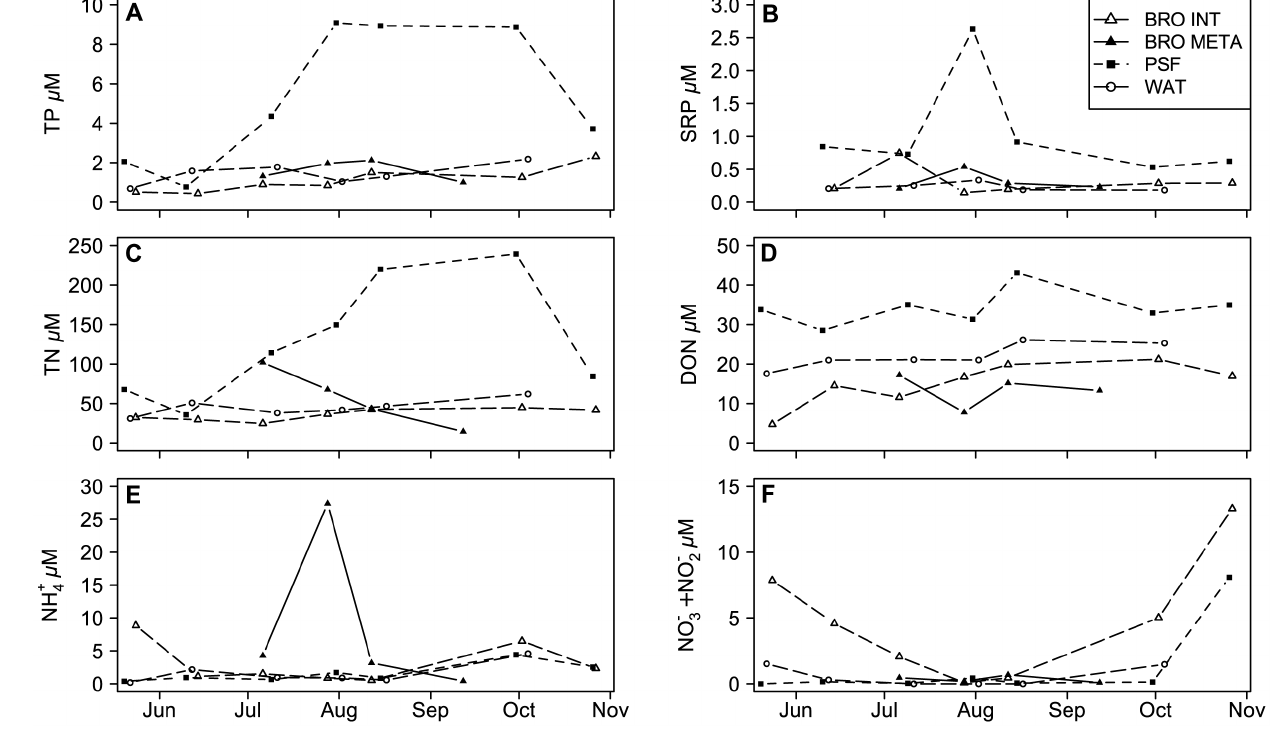
Figure 1. Concentration of nutrients ( m M) from April to October in the three study lakes. A) TP, B) SRP, C) TN, D) DON, E) NH 4 + , and F) NO 3 2 + NO 2 2 . BRO INT, integrated samples from the epilimnion of lake Bromont; BRO META, samples from the metalimnion of lake Bromont; PSF, Petit Lac St. Franc¸ois; WAT, Lake